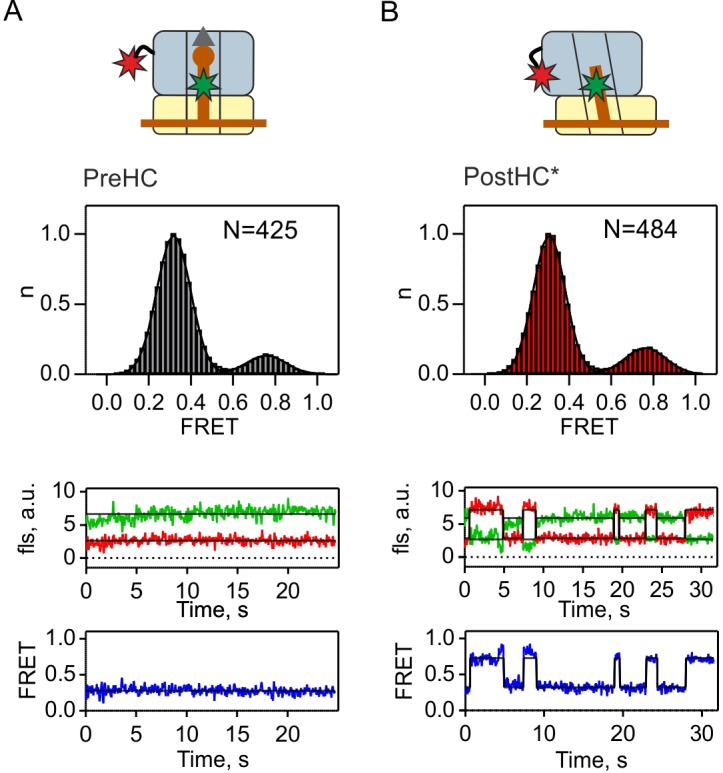
tRNA conformation in PreHC and PostHC*.Distribution of P/P and P/E-like states in PreHC and PostHC* with FRET labels on tRNAfMet and protein L1 in the absence of termination factors as well as representative example traces. Gaussian fits of FRET signals center at 0.76 ± 0.02 (mean ±sd) and 0.32 ± 0.01 (A) and 0.76 ± 0.01 and 0.31 ± 0.01 (B). FRET values were calculated from three independent datasets.